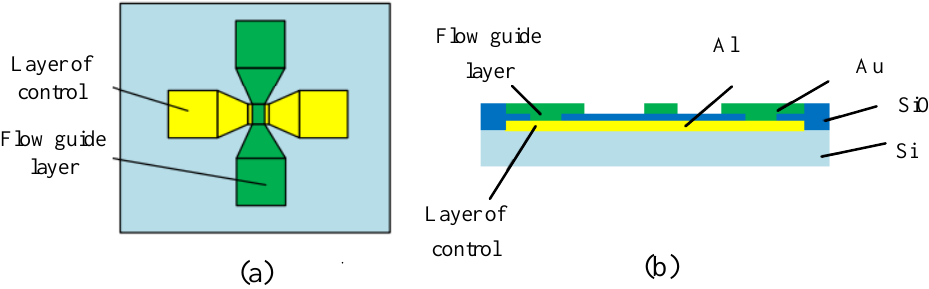
Figure 2. Fuse-logic control chip solid - state ON – OFF switch basic functional unit. ( a ) Top view of the solid - state ON – OFF ( b ) Bridge section view of the solid - state ON – OFF.